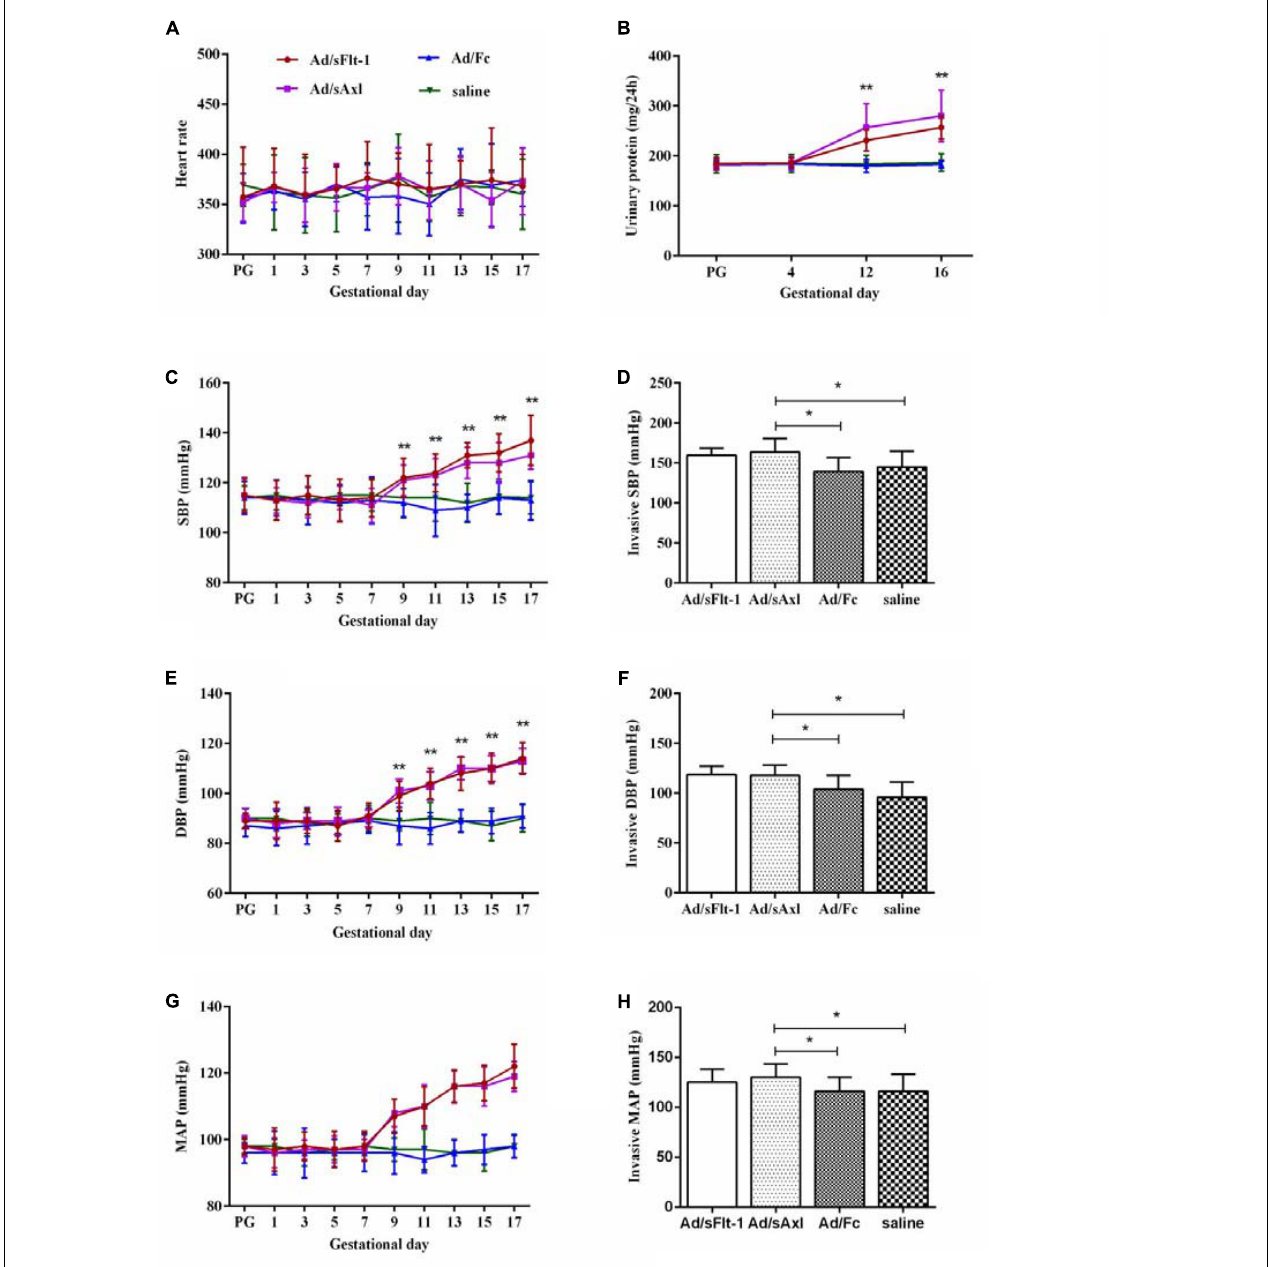
FIGURE 5 | Effects of sAxl on preeclampsia-like symptoms of pregnant rats. (A,C,E,G) Heart rate, systolic blood pressure (SBP), diastolic blood pressure (DBP), and mean arterial pressure (MAP) were measured at baseline and from the first day to the 17th day of pregnancy in four groups. (B) Urine protein level. (D,F,H) Invasive SBP, invasive DBP, and invasive MAP. The results are presented as mean ± SD. * p < 0.05, ** p < 0.01 vs. respective controls. n = 6 per